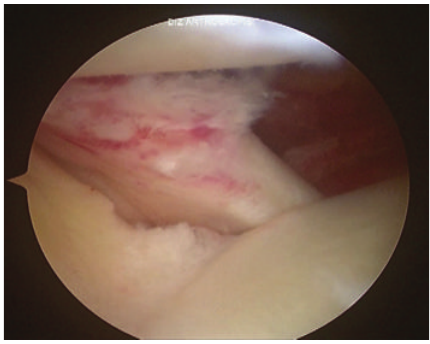
Figure 2: Arthroscopic view of injured popliteus tendon.